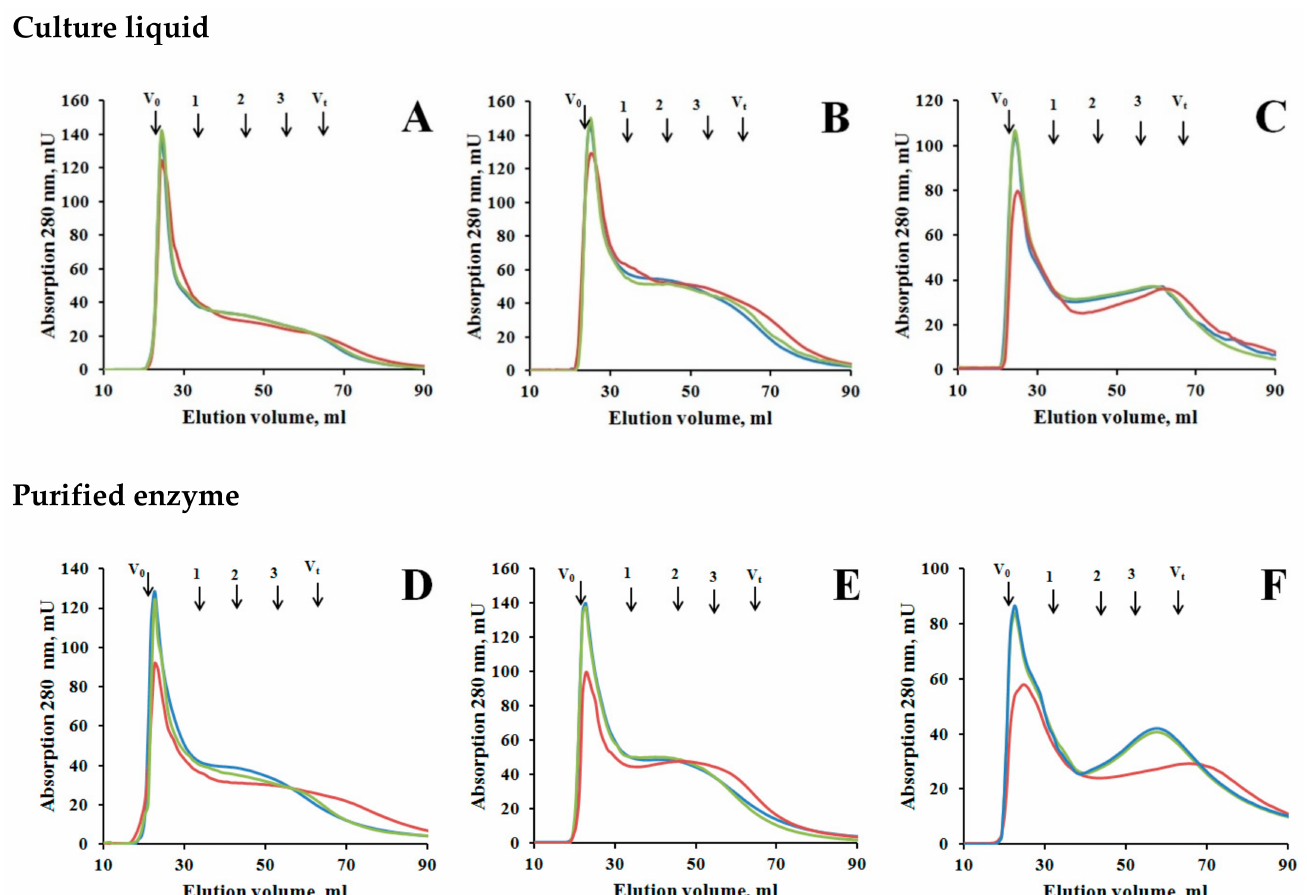
Figure 4. Transformation of the HA by laccase-containing culture liquid of M. elasson ( A – C ) and by the purified laccase ( D – F ): ( A or D )—Retisol HA, ( B or E )—compost HA, ( C of F )—Merck HA. The green line is initial HA, the blue line is the reference with inactivated laccase, the red line is transformation of HA by laccase. Arrows indicate the void volume (V 0 > 80 kDa), the total void volume (V t < 5 kDa), 1—bovine serum albumin (66 kDa), 2—carbonic anhydrase (29 kDa), 3—cytochrome C (12.4 kDa). The experimental data presented in Supplementary Materials—“supplement gel-filtration culture liqued.xlsx” and “supplement gel-filtration